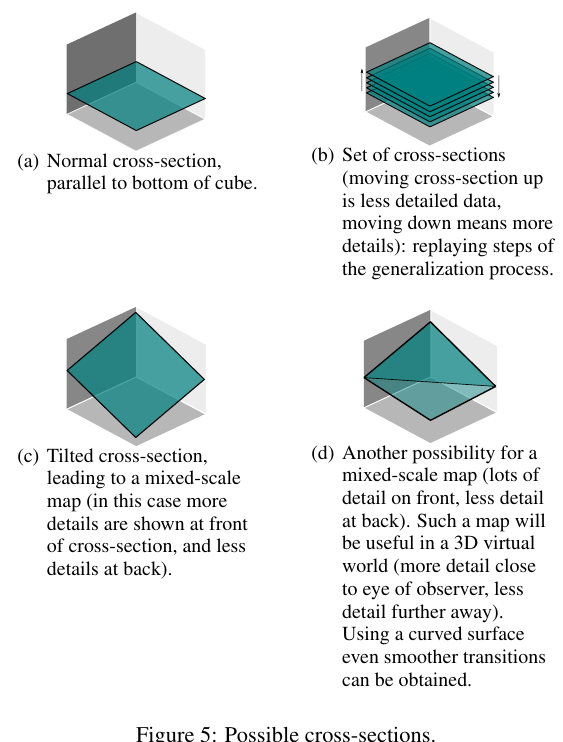
Figure 5: Possible cross-sections.